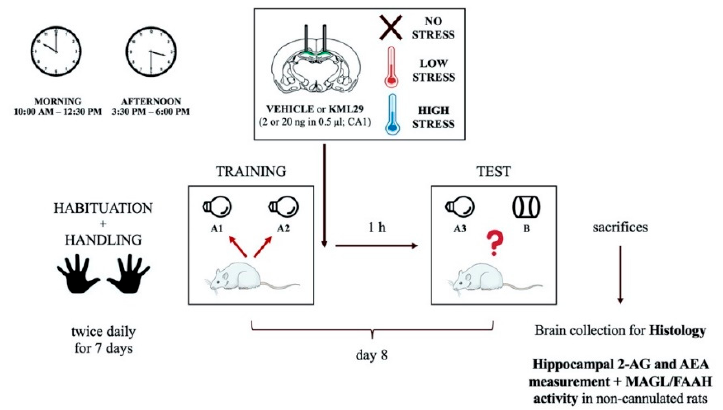
Figure 5. Diagram of the experimental procedures.